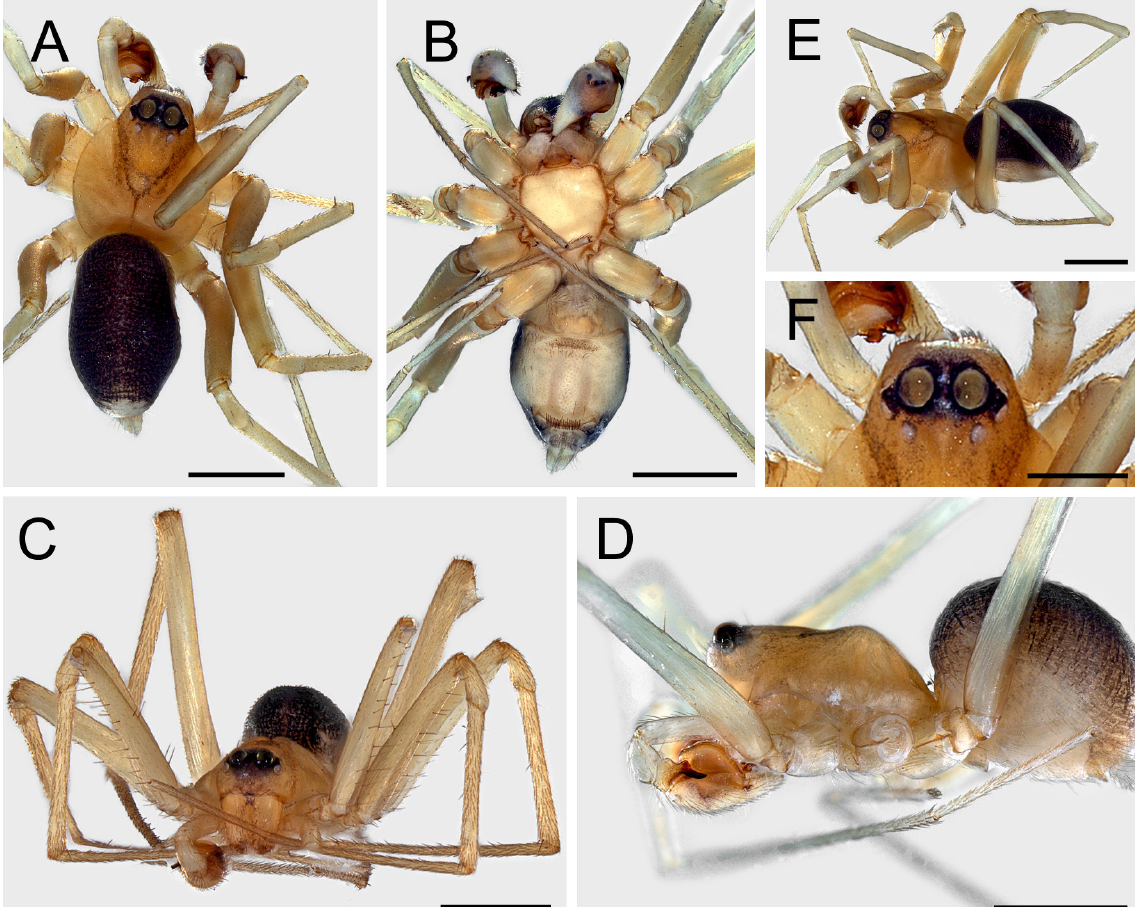
Fig. 4. Acanthinozodium sahelense sp. nov., holotype ♂. A . Habitus, dorsal view. B . Idem, ventral view. C . Idem, frontal view. D . Idem, lateral view. E . Idem, dorsolateral view. F . Carapace, eye region, dorsal view. Scale bars: A–E = 1 mm; F = 0.5